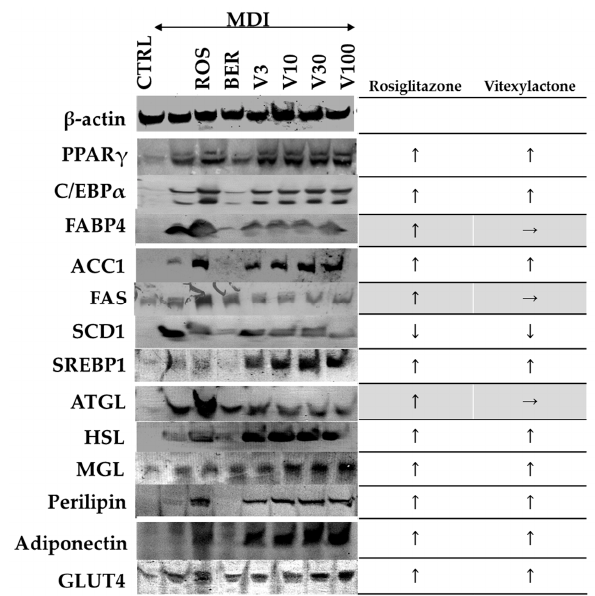
Figure 7. The effects of each compound on adipogenesis-related proteins, adiponectin, and, GLUT4 levels in 3T3-L1 cells on day 8. The 3T3-L1 cells were cultured in 6-well plates and differentiated with DMI mixture with or without each compound under the conditions described in the Materials and Methods section and subsequently lysed with lysis buffer. Cell lysates were collected using a cell scraper and centrifuged at 15,000× g for 30 min at 4 °C. The supernatant was collected and the overall protein concentration was determined by a Protein Assay Reagent Kit (Cytoskeleton, Denver, CO, USA) with BSA as the standard. To detect GLUT4, membrane protein was extracted using Plasma Membrane Protein Extraction Kit according to the instructions of the manufacturer. Protein levels were measured by electroblotting. → , ↑ and ↓ represent no change, up- or down-regulation, respectively.